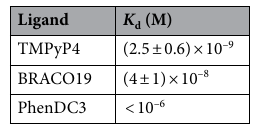
Table 2. Dissociation constants of the studied ligands to